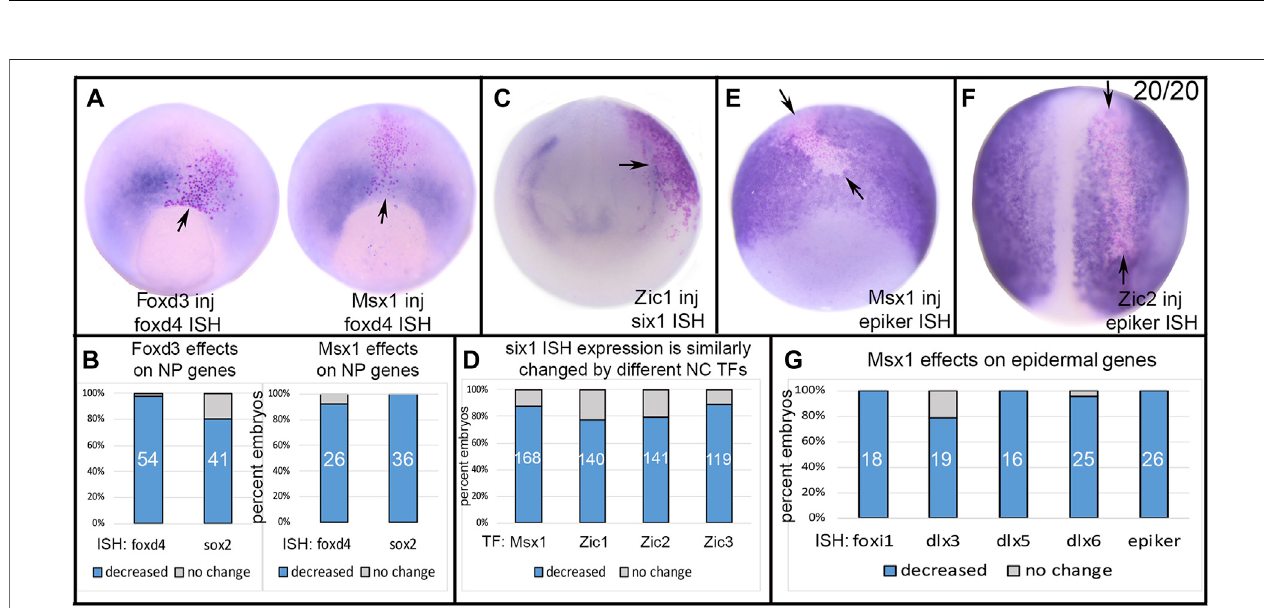
FIGURE 3 | The effects of expressing NC-enriched transcription factors in ectopic domains. (A) Ectopic expression of Foxd3 or Msx1(NC TFs) in a neural plate precursor blastomere resulted in reduced expression of foxd4 (NP TF) only in the region of the lineage-labeled cells (red dots, arrow). Vegetal views at midgastrula (st 11.5) withdorsal to thetop. (B) Thepercentage ofembryos inwhich theneural plateexpression of foxd4 or sox2 were reduced by ectopic expression of eitherFoxd3 or Msx1. Numberswithin thebars denotesamplesize. (C) Ectopicexpression ofZic1 (NCTF)inaplacode precursor blastomere reducedthe PPRexpression of six1 (arrow) in cells expressing Zic1 (red dots). Anterior view with dorsal to the top. (D) The percentage of embryos in which the PPR expression of six1 was reduced by ectopic expression of four different NC TFs. Numbers within the bars denote sample size. (E) Ectopic expression of Msx1 (NC TF) in an epidermis precursor blastomere reduced the Epi expression of epiker (between arrows) only in cells ectopically expressing Msx1 (red dots). Ventral view of gastrula stage with dorsal to the top. (F) Ectopic expression ofZic2 (NC TF) in an epidermis precursor blastomere reduced the Epi expression of epiker (between arrows) only in cells ectopically expressing Zic2 (red dots). Dorsal view of neurula stage with anterior to the top. (G) The percentage of embryos in which the expression of several Epi genes was reduced by ectopic expression of Msx1. Numbers within the bars denote sample size.